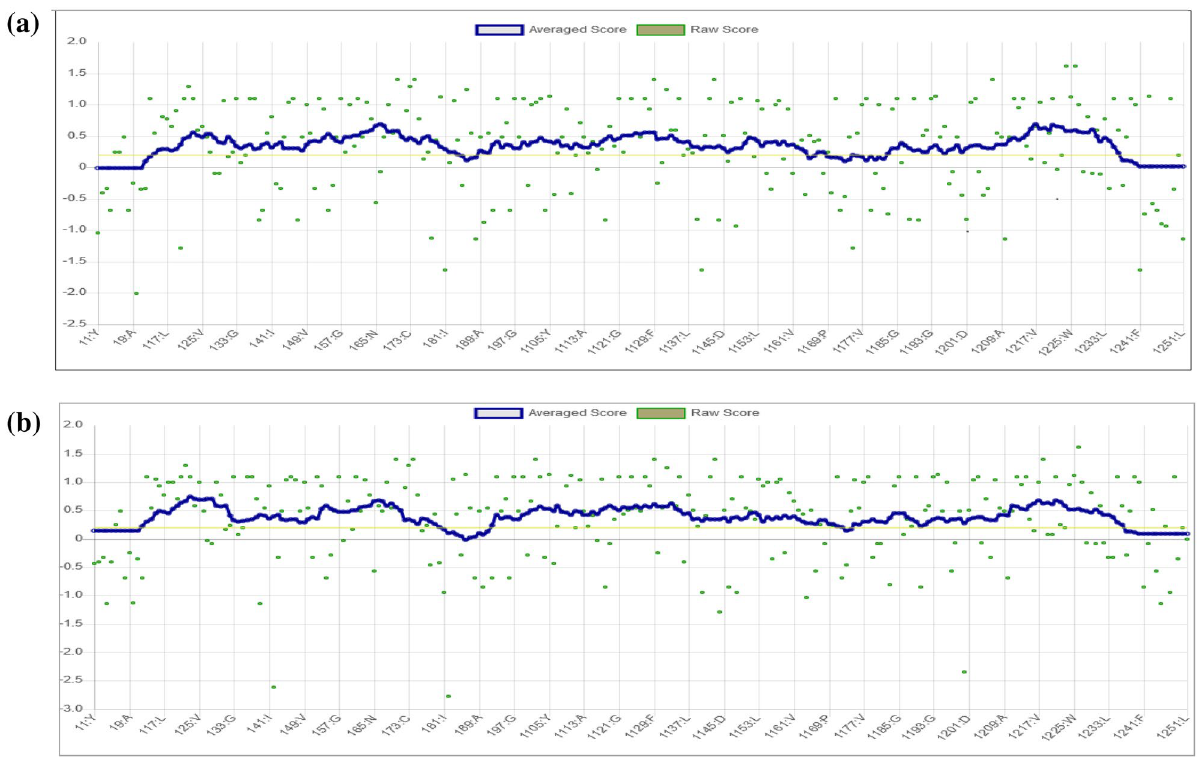
Figure 9. The results for Verify3D for AQP-3 protein model ( a ) before ( b ) after energy minimization. Polyphenolic